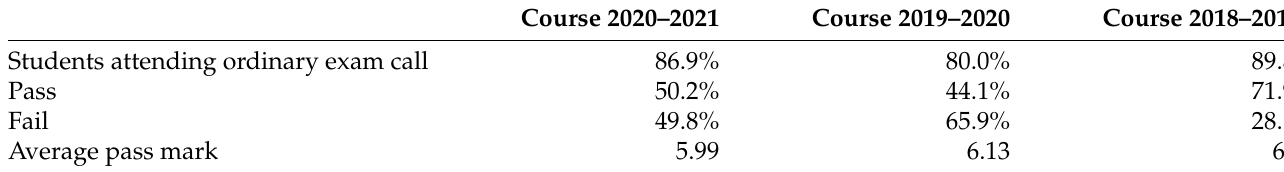
Table 13. Results of Pharmacy Ordinary Exam Call.